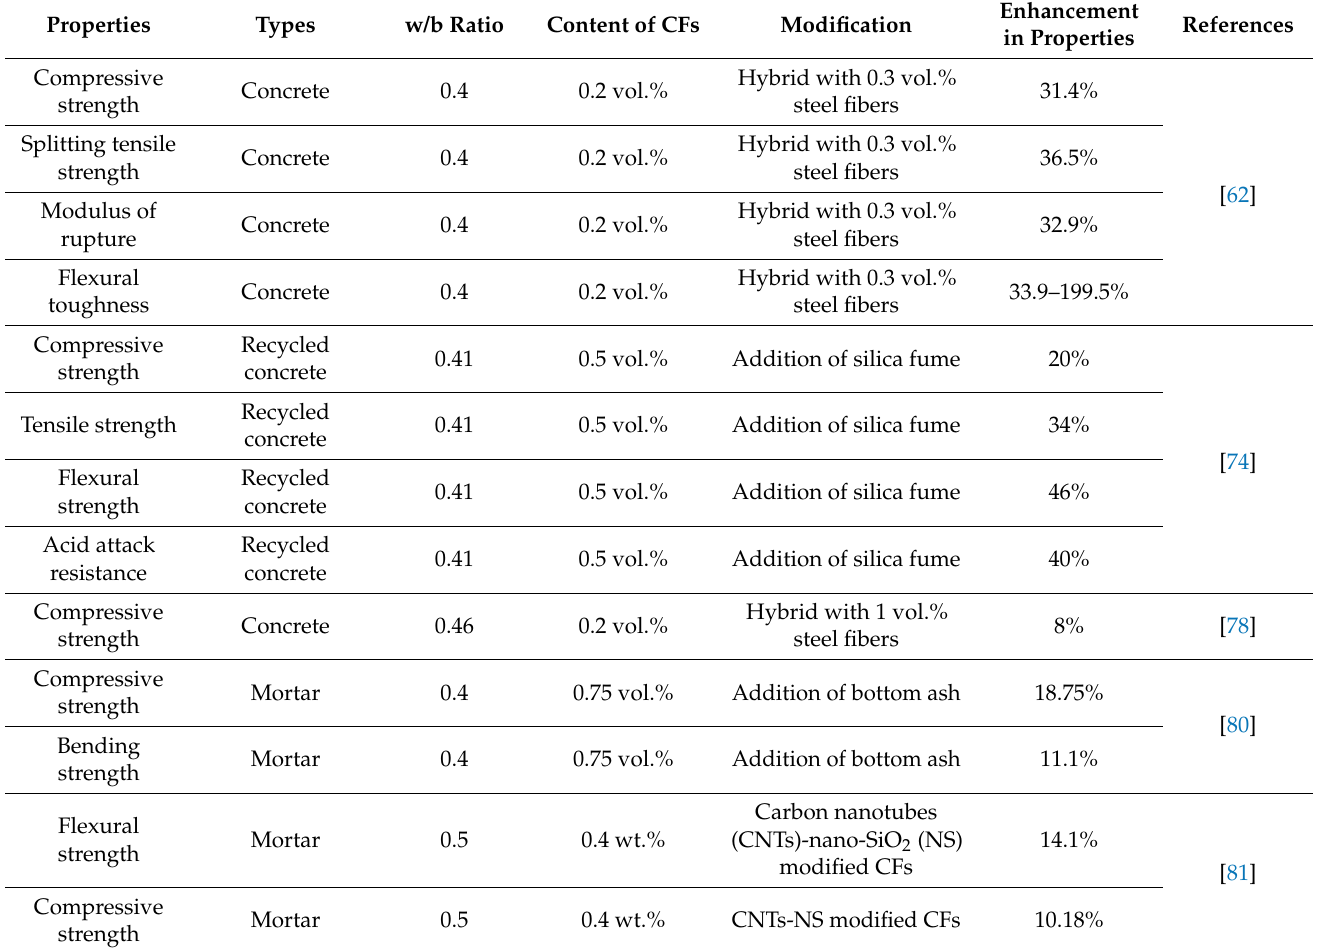
Table 2. Mechanical and durability properties of physically modified